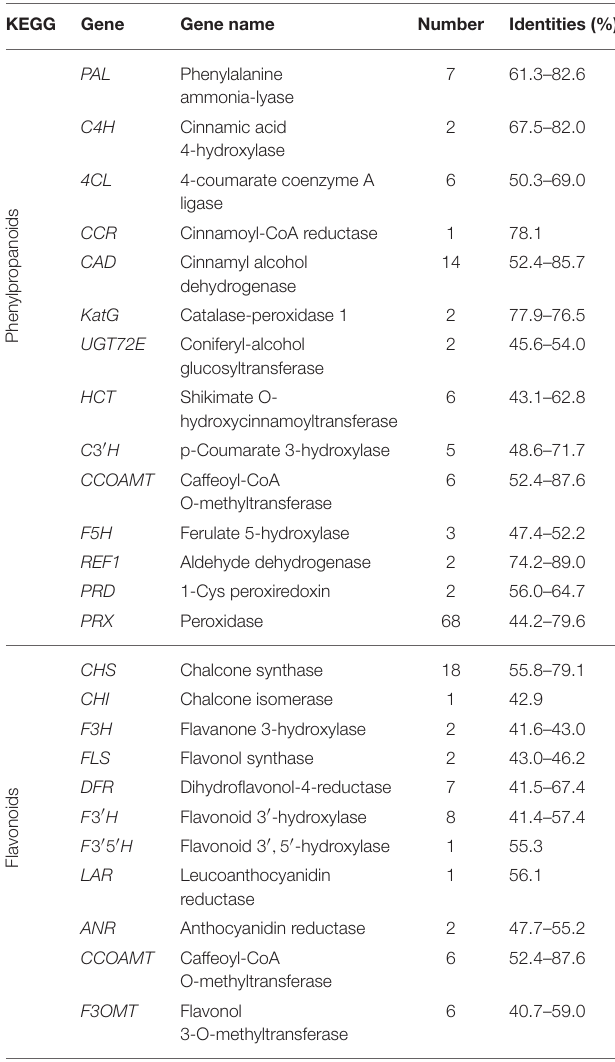
TABLE 1 | Candidate unigenes involved in biosynthetic pathways of phenylpropanoids and flavonoids in the transcriptome of Gnetum parvifolium